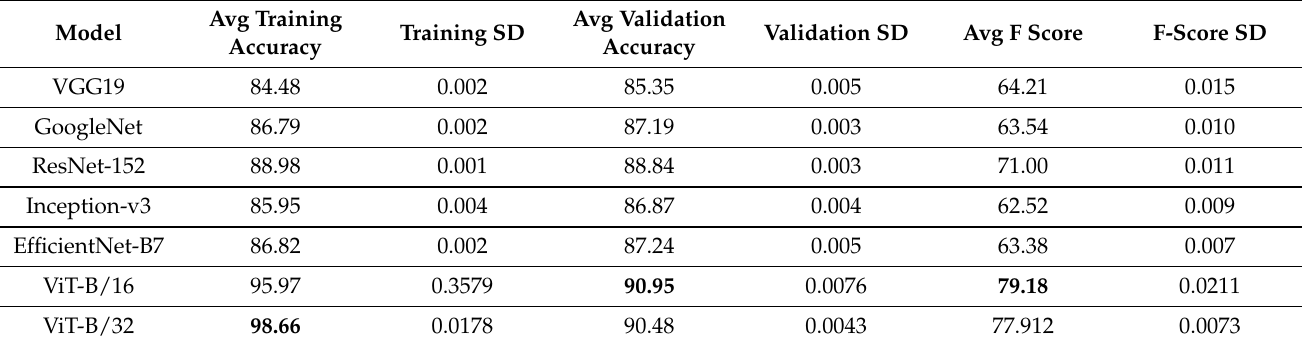
Table 4. Multi-label classification results for road weather detection using class weighted loss function to force models to handle rare weather conditions (best performance in